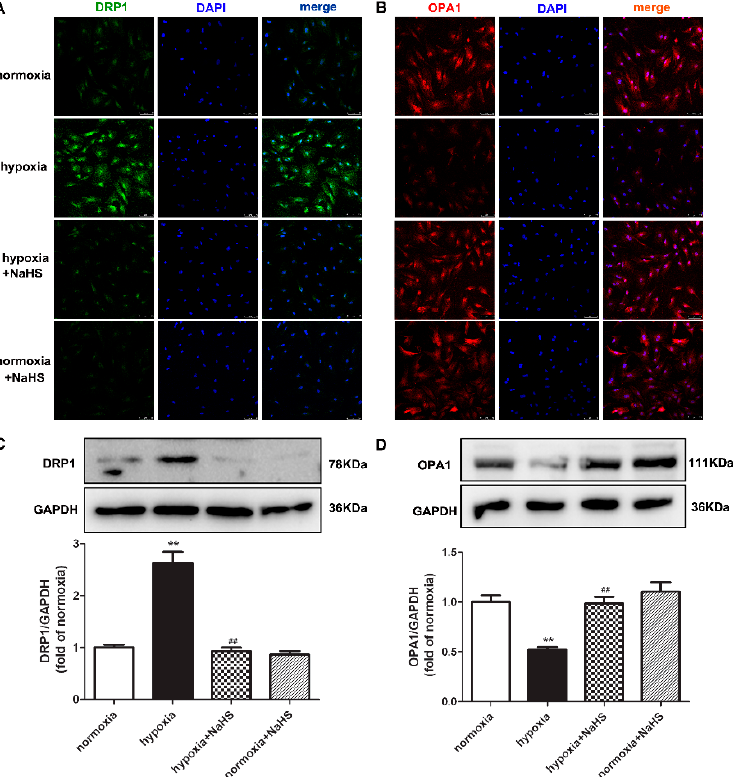
Figure 4. NaHS restored the DRP1 and OPA1 protein expression in cardiac fibroblasts with hypoxia. After pre-administration with NaHS (50 μ M) for 4 h, neonatal rat cardiac fibroblasts were subjected to normoxia (containing 5% CO 2 and 95% O 2 ) or hypoxia (containing 5% CO 2 and 1% O 2 ) for 4 h. ( A , B ) DRP1 and OPA1 were immunofluorescence stained with Alexa Fluor 488 (green) and Cy3 (red) conjugated IgG, respectively. The nuclei were stained with DAPI (blue). Bar = 75 μ m. ( C , D ) DRP1 and OPA1 protein expression were detected by Western blot. ** p < 0.01 vs. normoxia, ## p < 0.01 vs. hypoxia, n = 6.